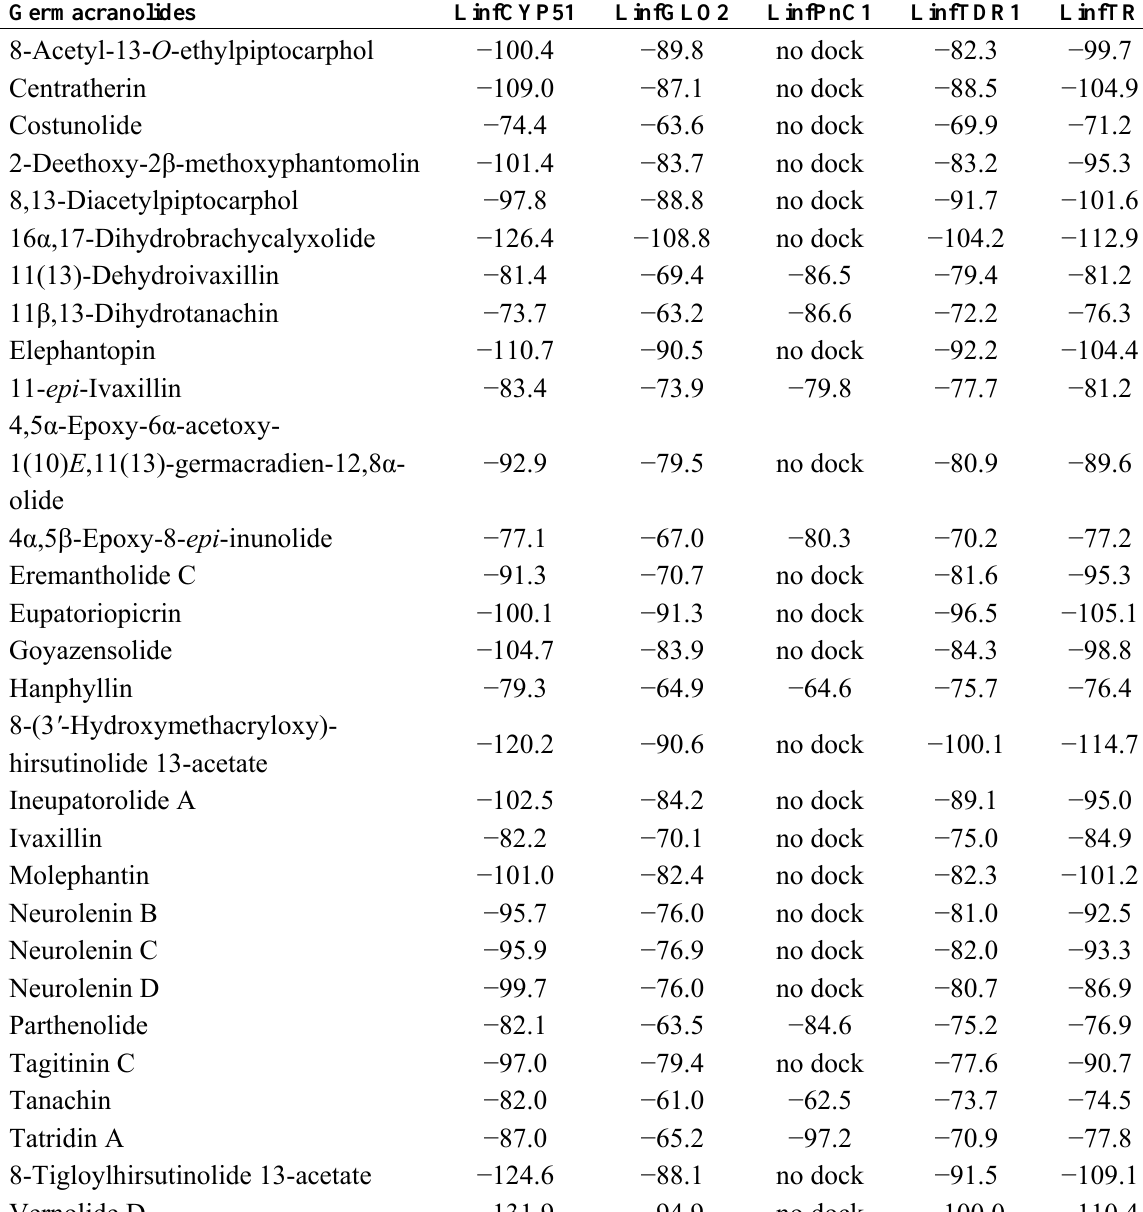
Table 6. MolDock docking energies (kJ/mol) of germacranolide sesquiterpenoids with Leishmania infantum protein